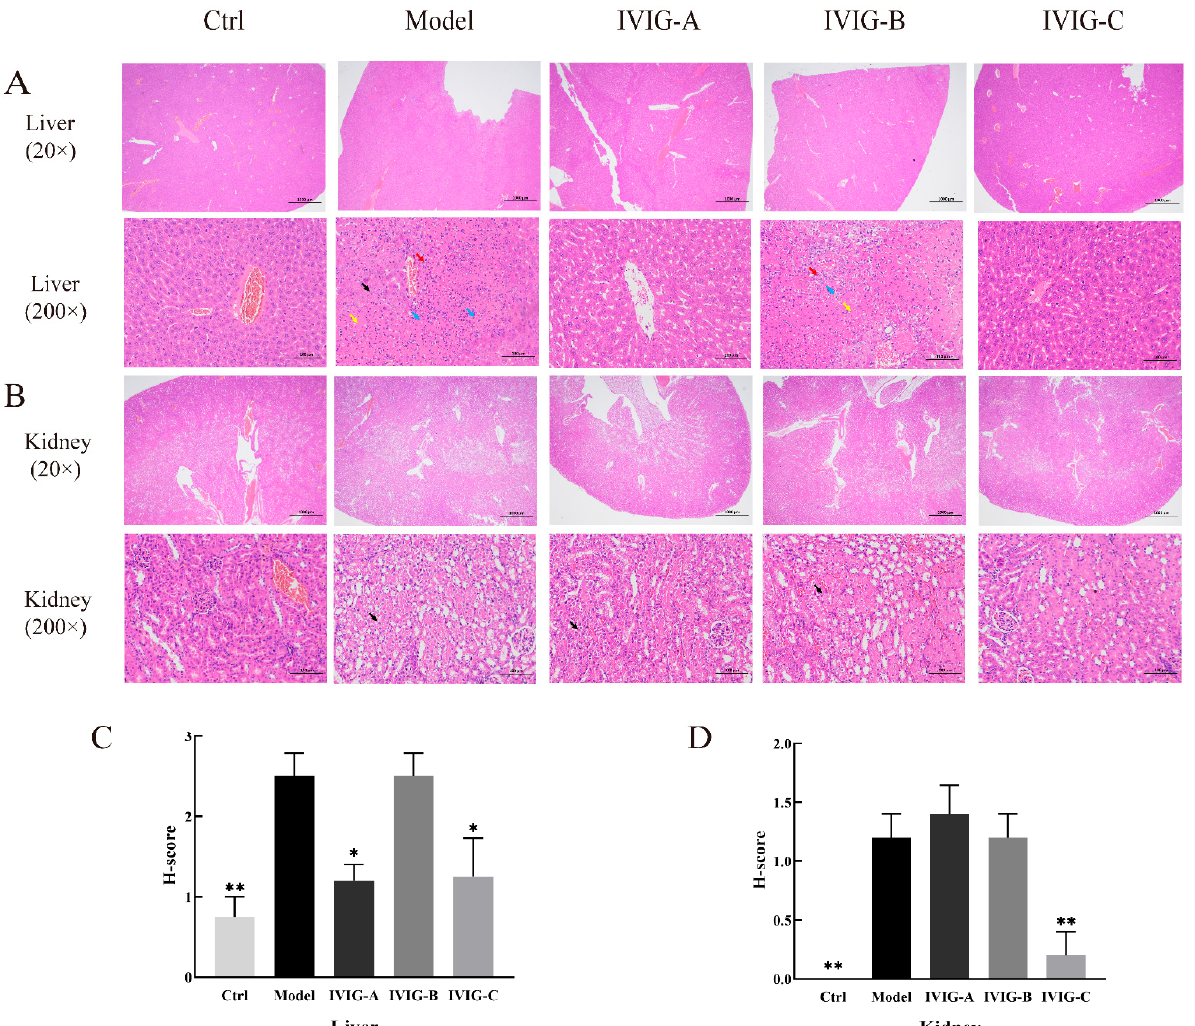
Figure 3. The histopathological changes of the liver ( A ) and kidney ( B ). IVIG exerted different degrees of ameliorating effects on the liver and kidney damage. The black arrow indicates mild watery degeneration of the cell, swelling of the cell, and loose and bright cytoplasm; The yellow arrow indicates focal necrosis and karyolysis of hepatocytes; The red arrow indicates a small amount of connective tissue hyperplasia; The blue arrow indicates punctate lymphocyte and neutrophil infiltration. The H-score was used to grade the severity of the lesion of the liver ( C ) and kidney ( D ). Ctrl, control group; Model, LPS injection (Model) group; Data are expressed as the mean ± SEM. Statistical significance using one-way ANOVA defined as * p < 0.05, ** p < 0.01 vs. Model group ( n = 4).